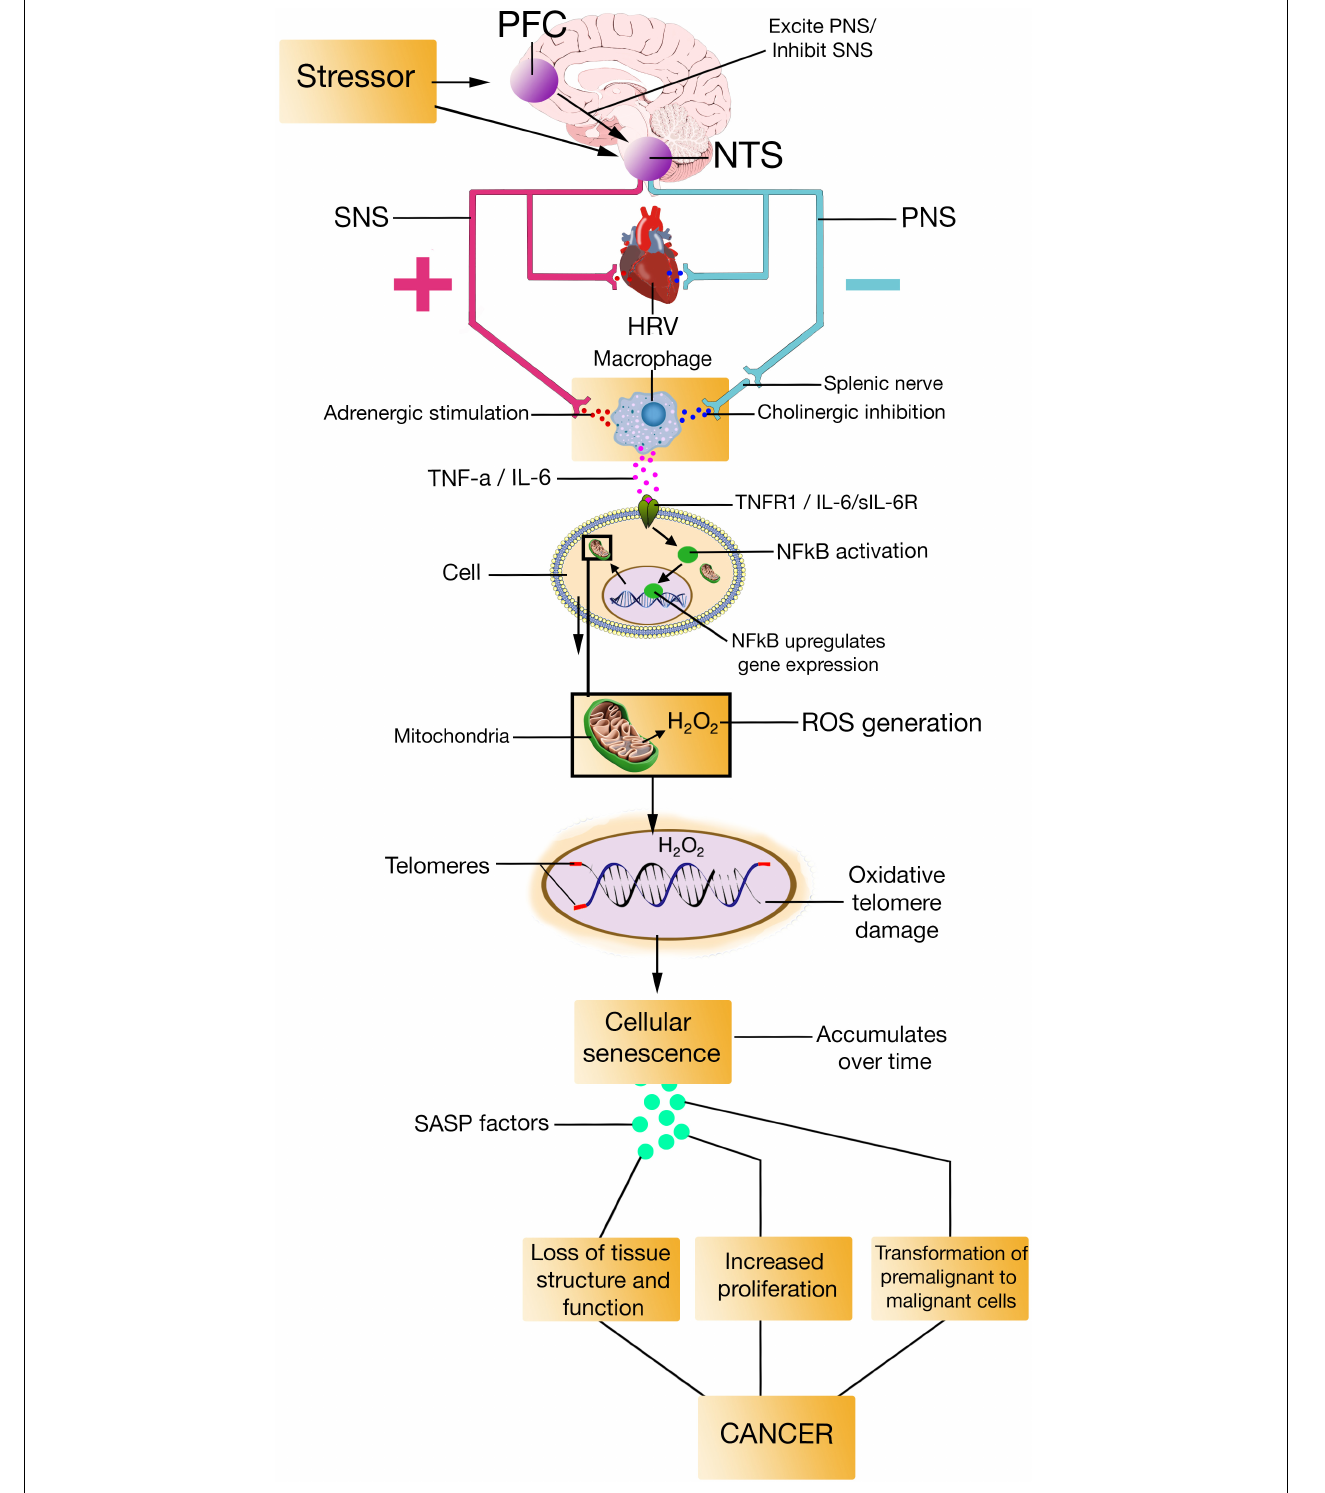
FIGURE 3 | PFC, prefrontal cortex; NTS, nucleus of the tractus solitarius; SNS, sympathetic nervous system; PNS, parasympathetic nervous system; HRV, heart rate variability; TNF-a, Tumor Necrosis Factor-alpha; IL-6, interleukin-6; TNFR1, Tumor Necrosis Factor-alpha Receptor 1; sIL-6R, soluble interleukin-6 receptor; NFkB, Nuclear factor kappa light chain enhancer of activated B cells; H2O2, hydrogen peroxide; ROS, reactive oxygen species; SASP, senescence-associated secretory phenotype.